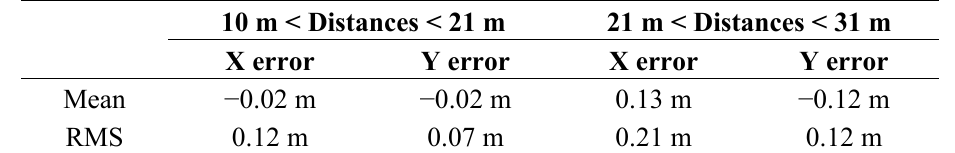
Table 3. Mean and RMS error in object coordinates of the 32 points measured with total